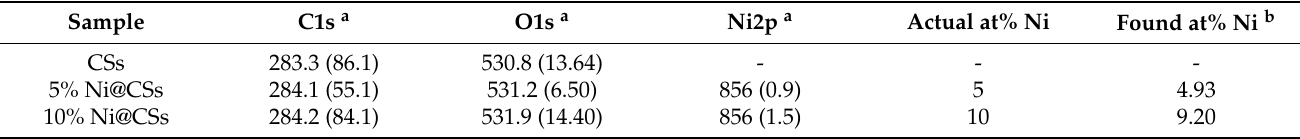
Table 1. Binding energies and surface contributions of C1s, O1s, and Ni2p of the